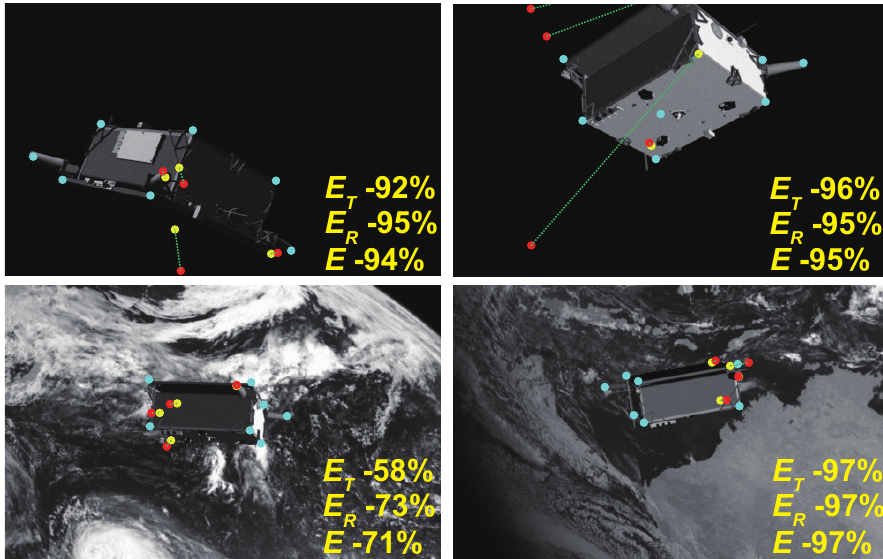
Figure 7. Uncertainty Prediction Helps Reduce Pose Estimation Error. The blue points represent the key points that we retained for pose estimation, the red points represent the key points that we eliminated due to the high uncertainty, the yellow points represent the true positions of the eliminated keypoints, and we used the green dotted line Connect the corresponding yellow and red points.